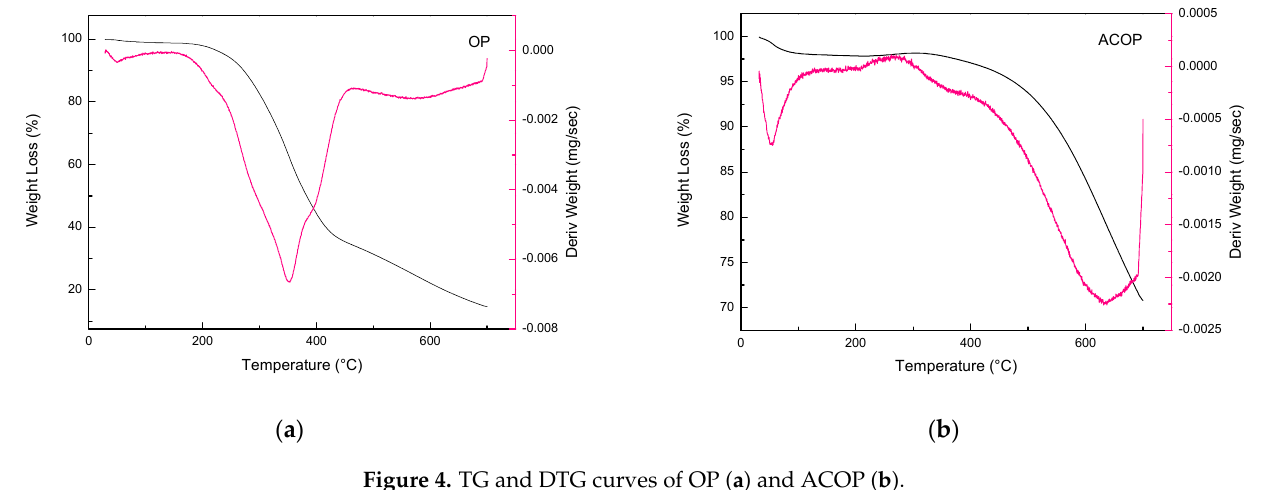
Figure 4. TG and DTG curves of OP ( a ) and ACOP ( b ).